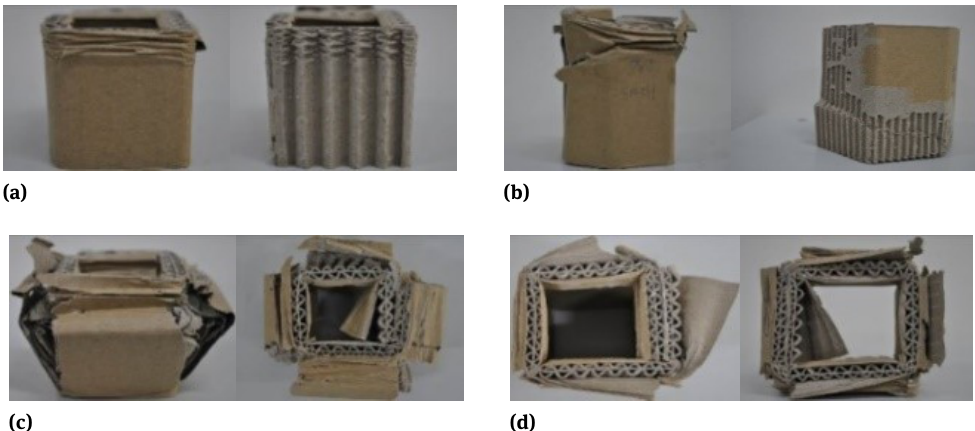
Figure 2: Deformation modes of Y-direction paper corrugation tube: (a) stable progressive buckling, (b) Euler instability, (c) corner tearing and (d) transverse